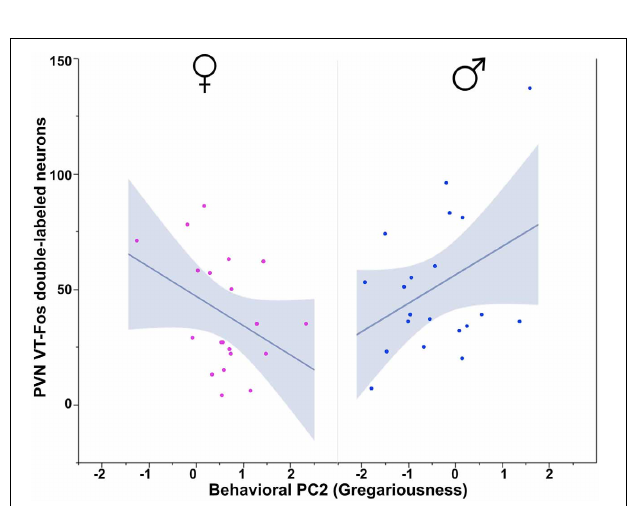
exposed to familiar same-sex conspecifics. Context × Behavioral PC1 F ( 1 , 32 ) = 8 . 48, p < 0 . 01. (B) Similar results are obtained for the numbers of PVN VT-Fos double-labeled neurons. Context × Behavioral PC1 F ( 1 , 32 ) = 14 . 71, p < 0 . 001. The 95% confidence interval is indicated by shading.